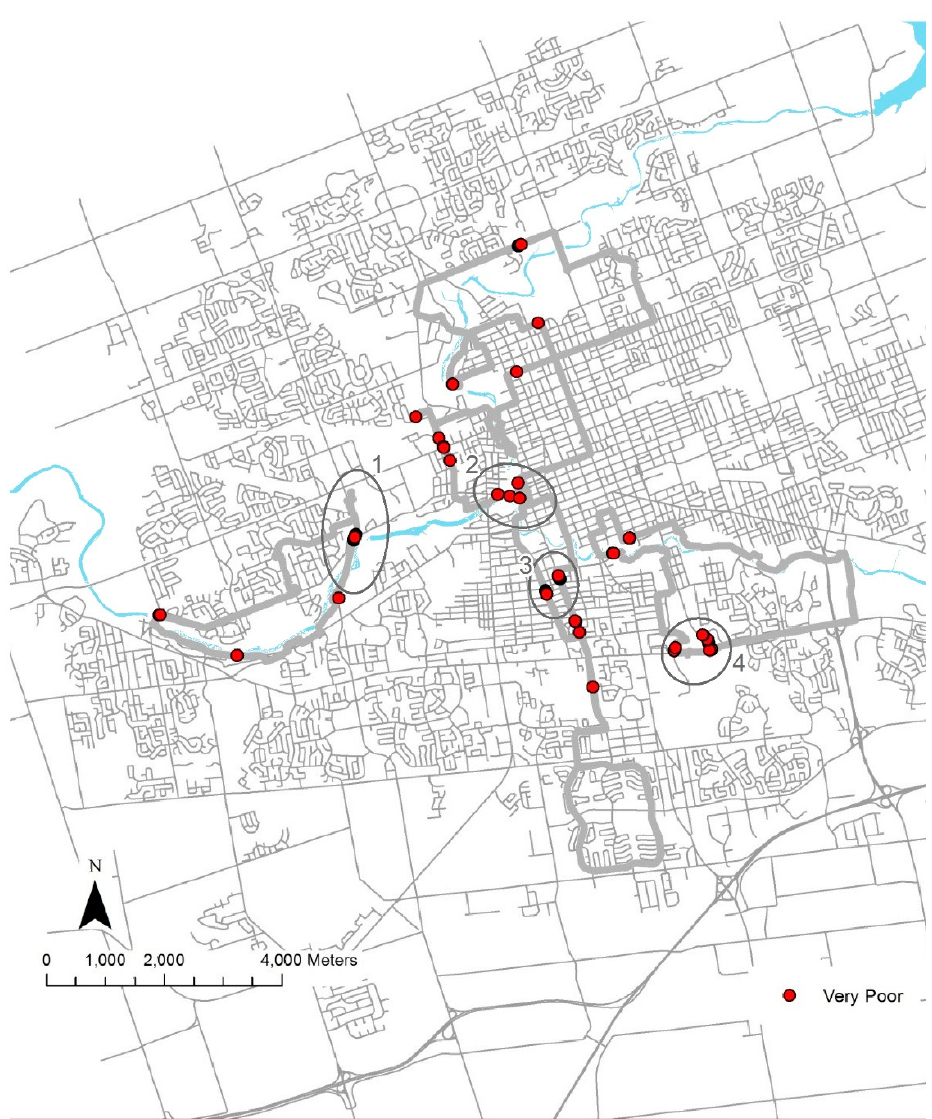
Figure 7. Map of London, Ontario highlighting very poor (PM 2.5 > 91 µg/m 3 ) pollution